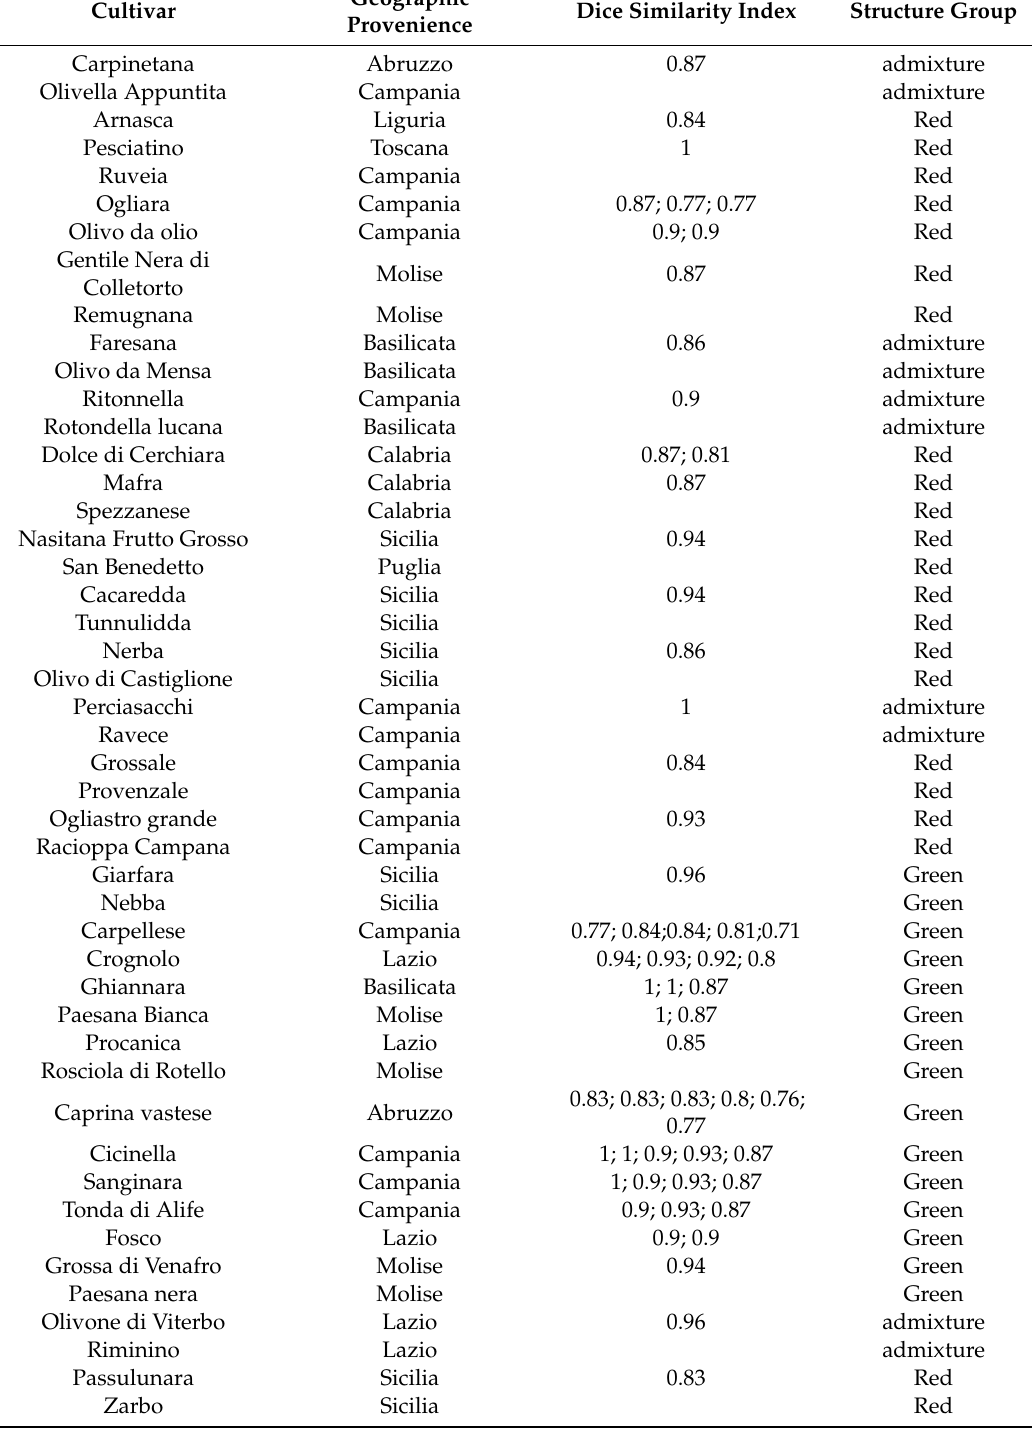
Table 4. List of the 17 synonymy groups found amongst the 120 olive varieties, their geographic origin, genetic similarity (Dice’s index), and the corresponding group found with the population structure